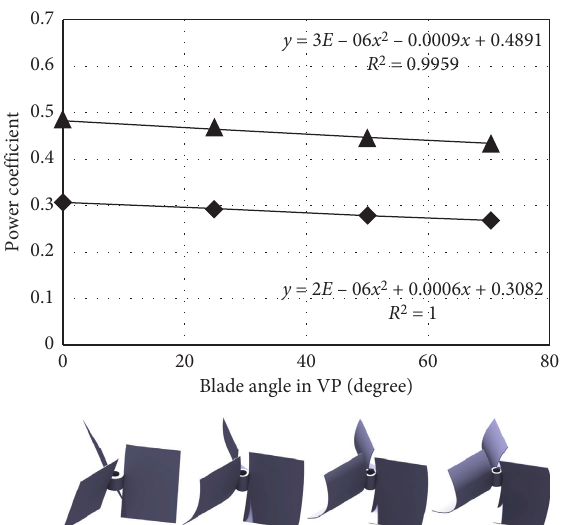
Figure 12: Set 2 data points (left to right—runners R3, R5, R6, and R7).